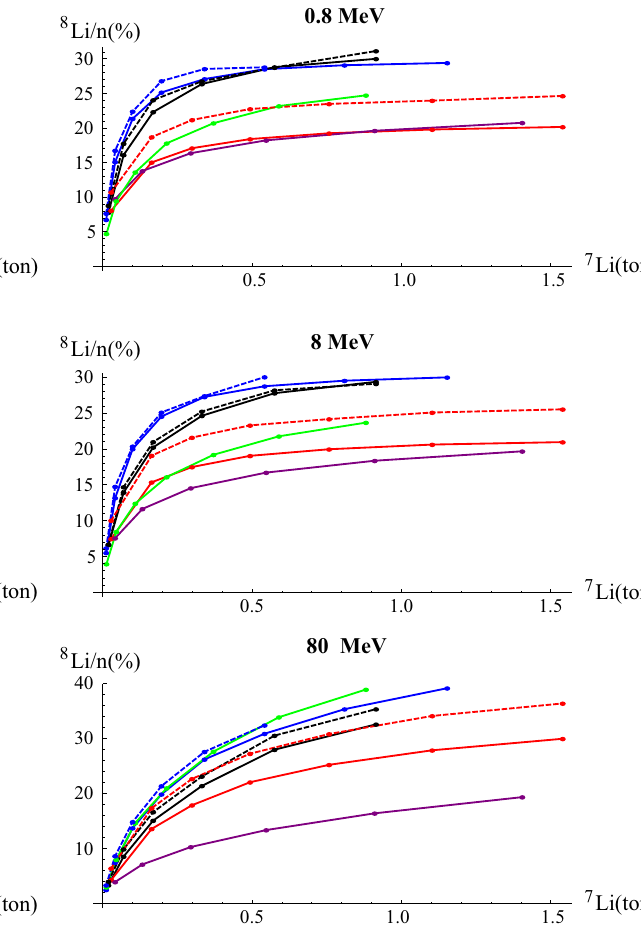
tively. Solid curves were produced with FLUKA and dashed curves with GEANT4. The horizontal axis is the mass of the 7 Li